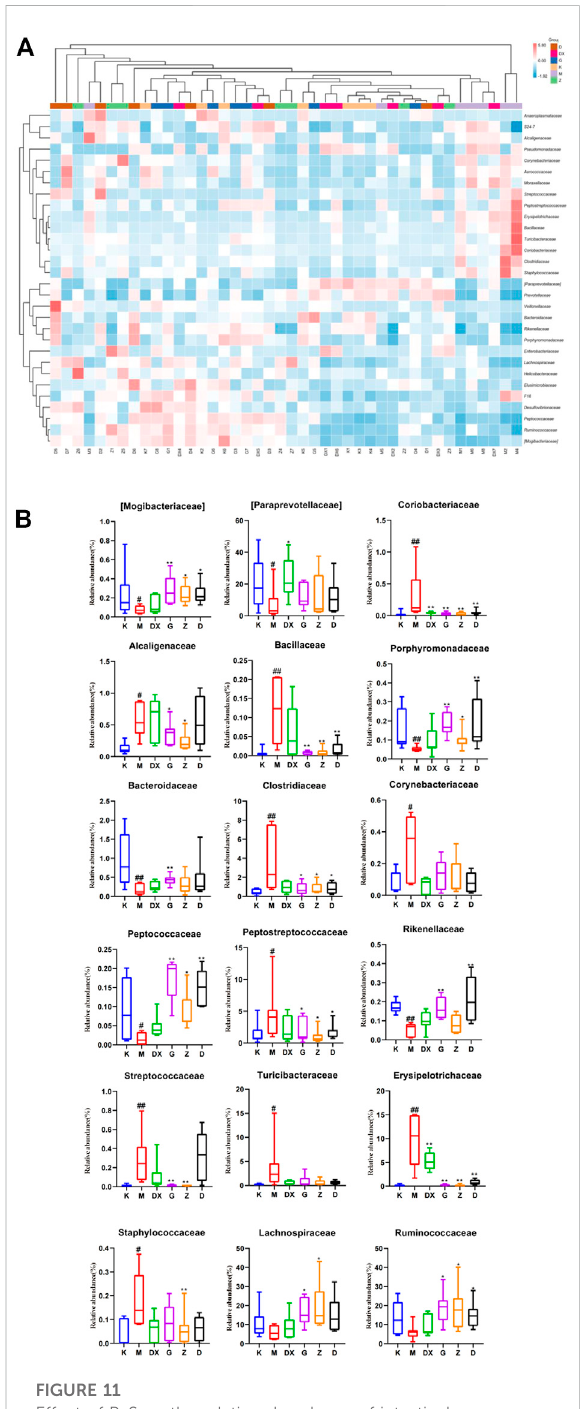
FIGURE 12 Effect of R-S on the relative abundance of intestinal micro fl ora (A) and signi fi cant changed intestinal micro fl ora (B) of insomniac rats ( n = 7) in